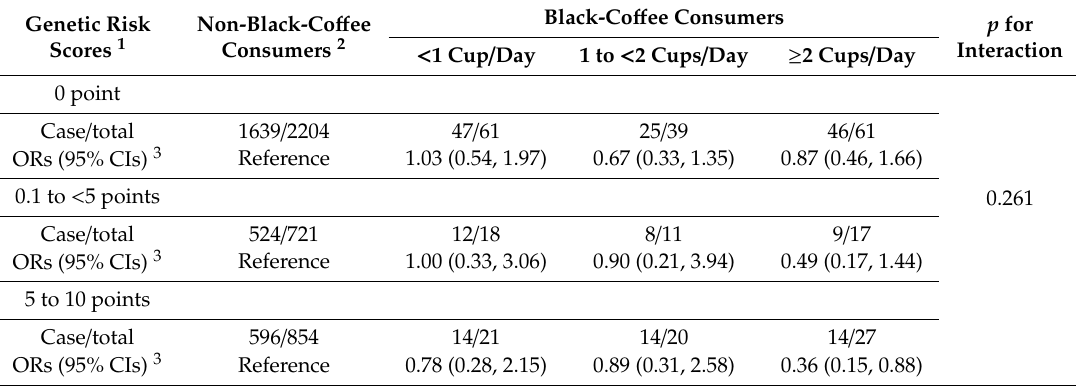
Table 5. Multivariate-adjusted ORs and 95% CIs for the risk of prediabetes and type 2 diabetes combined by genetic risk scores according to black co ff ee consumption.